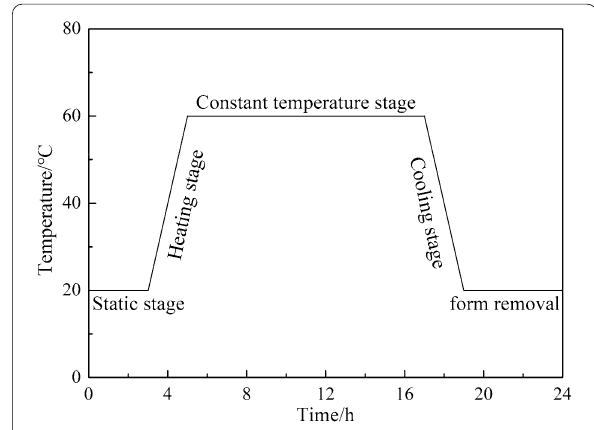
Fig. 2 Schematic diagram of the time–history curve of steaming system